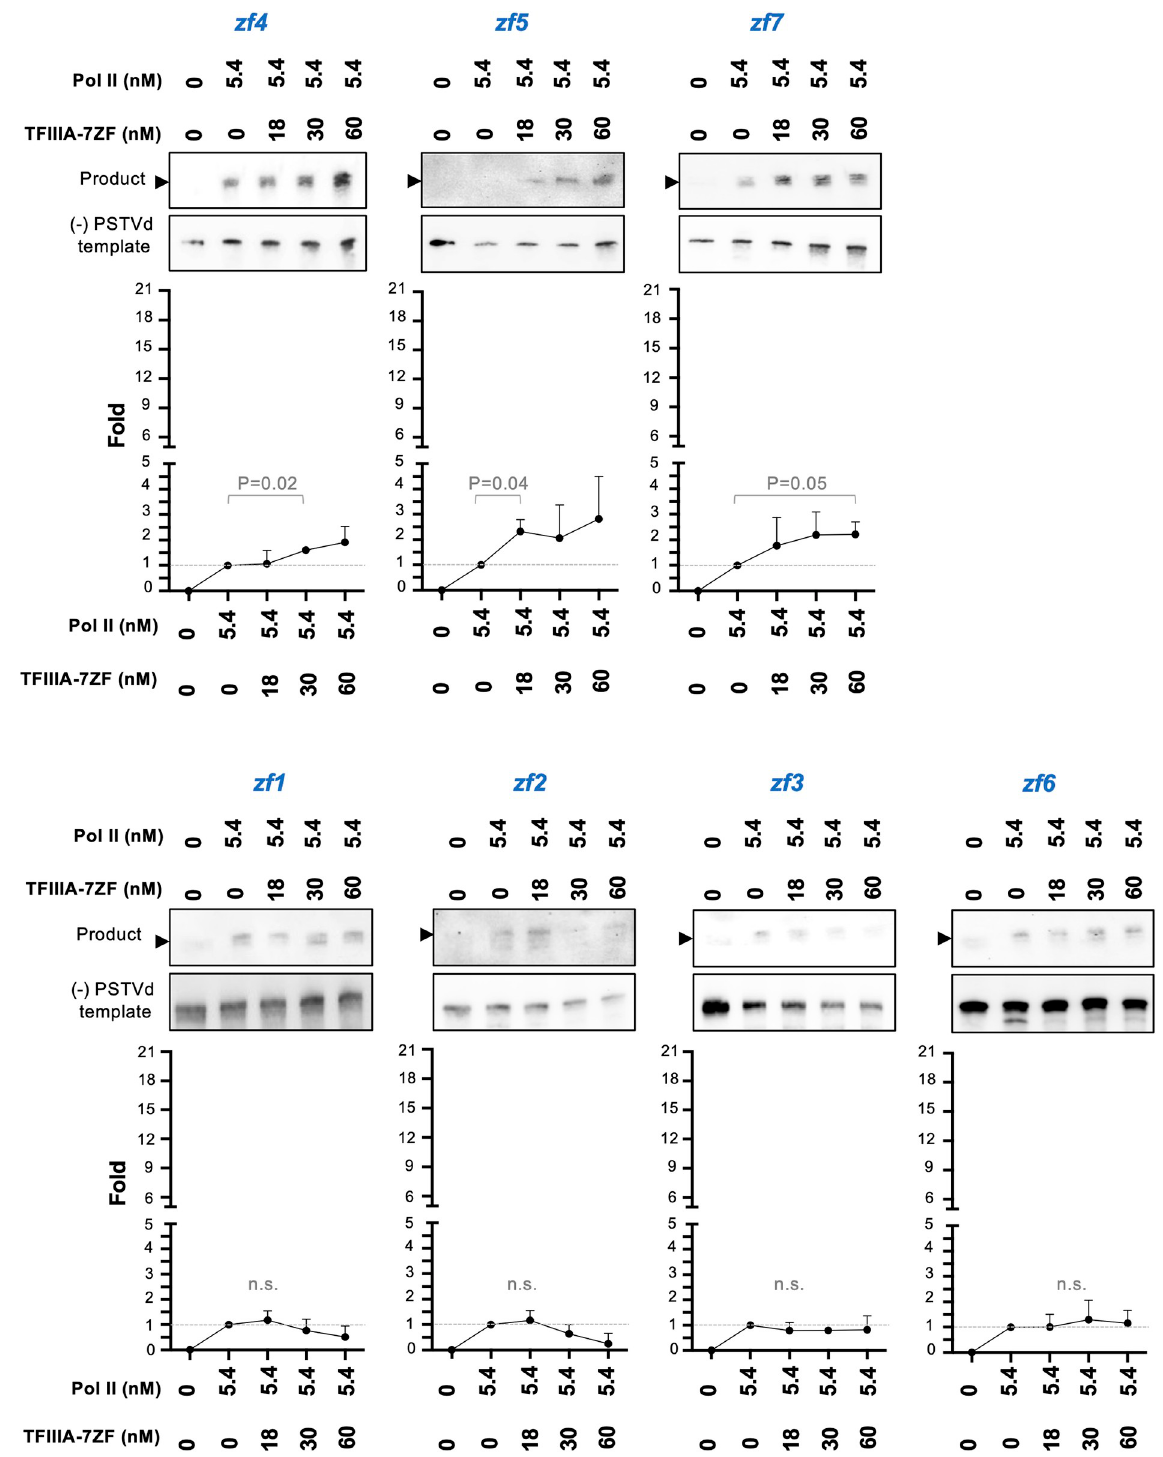
Fig 3. Analyses on the role of TFIIIA-7ZF zinc finger domains in aiding Pol II activity on RNA templates. Reconstituted in vitro transcription (IVT) system using partially purified Pol II (5.4 nM), (-) PSTVd dimer RNA (7.8 nM), and various amounts of TFIIIA-7ZF mutants. Sequence-specific riboprobes were used to detect (-) PSTVd templates and (+) PSTVd products. Arrowheads indicate the position of (-) PSTVd dimer template, based on the extremely low cross-reaction signals that were only visible after over-exposure. Fold changes were analyzed as described in Fig 1. P values for significant fold changes as compared with Pol II only samples were listed. n.s., no significant change was identified. Uncropped gel images were shown in S4 Fig.